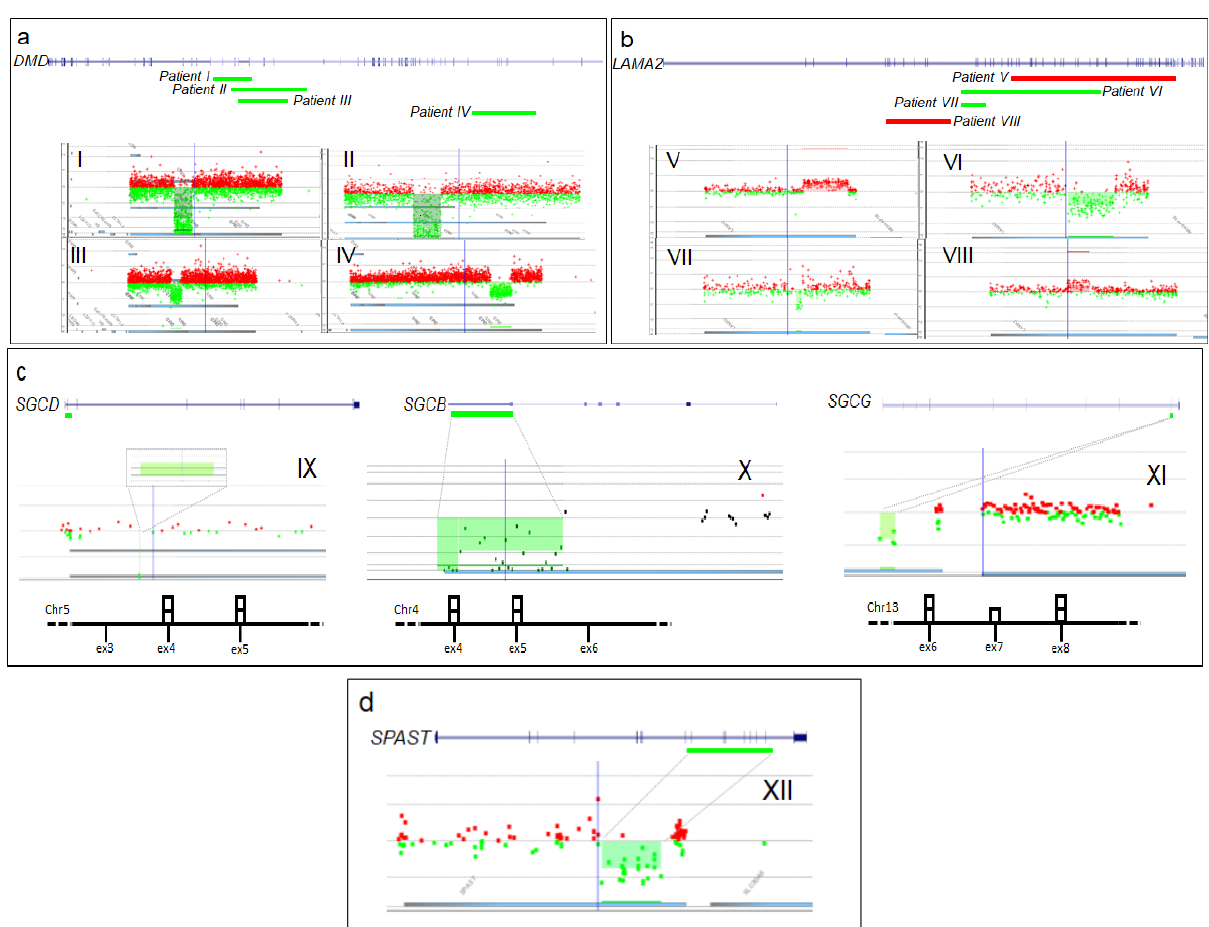
Figure 1. Graphic view of 12 causative copy number variants (CNVs). Gene representation and array CGH panels showing: ( a ) 4 DMD deletions (patients I–IV); ( b ) 2 deletions and 2 duplications in LAMA2 (patients V–VIII); ( c ) 3 deletions involving sarcoglycan genes (patients IX–XI); ( d ) SPAST gene deletion in patient XII. Green bars indicate deletions and red bars indicate duplications. The results of genomic quantification by real-time PCR are schematically represented (bottom of c ). The number of each coding exon along gene is surmounted by a square corresponding to the number of detected copies.